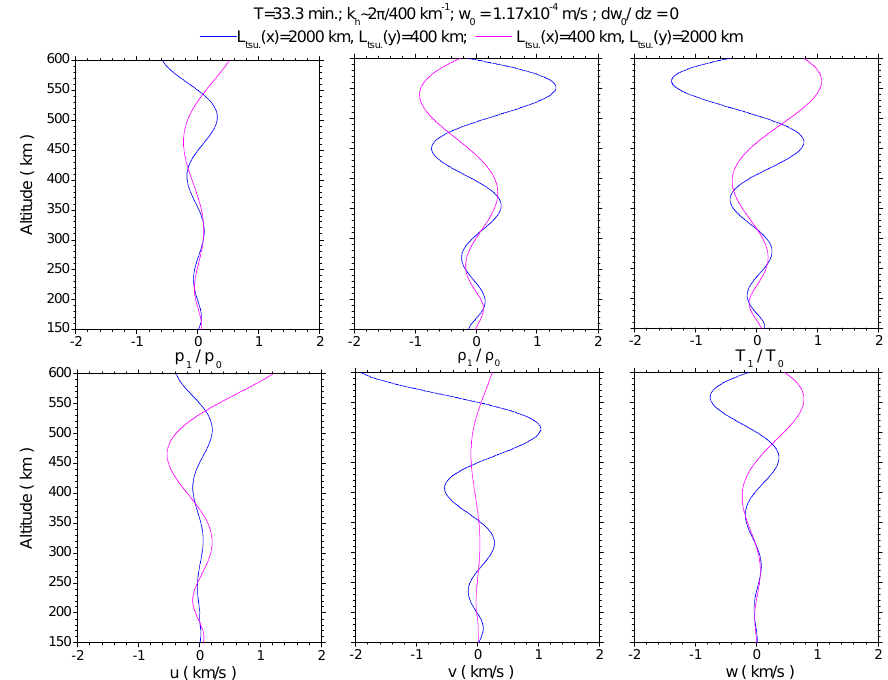
Figure 2. Amplification of upward propagating tsunami-driven surface waves in the form of atmospheric gravity waves in ionospheric F layer (150–600 km). The perturbations are calculated from Equation (4) under initial conditions at the sea level of w (given in Subsection 2.1) and assumed d w andHickey et al .’s horizontal wave number, λ specific horizontal scale sizes: ( x, y ) = (2000,400) km (in blue) and ( x, y ) = (400,2000) km (in